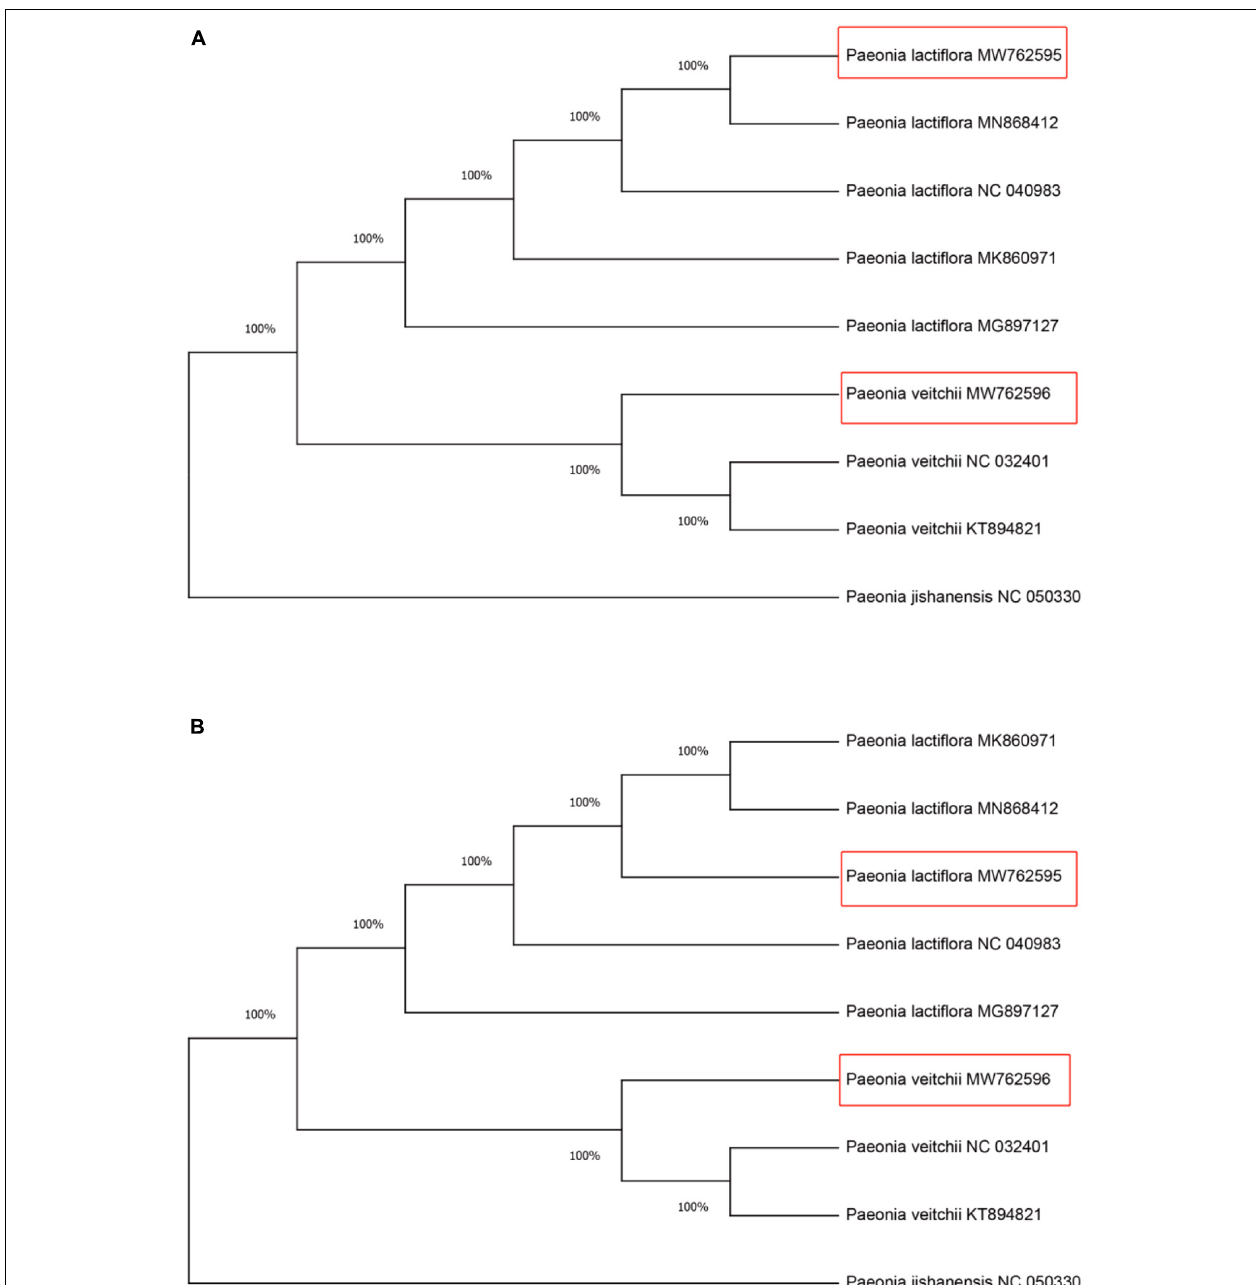
FIGURE 5 | Neighbor-Joining (NJ) tree of the Chishao species based on primers CS- ycf1b and CS- ndhF amplified sequences. (A) Primer CS -ycf1b ; (B) Primer CS -ndhF. Numbers beside nodes indicate statistical support for individual clades (percent), based on 1,000 bootstrap replicates of the data. Red boxes represent the assembled and annotated chloroplast genomes of Paeonia lactiflora and Paeonia veitchii in this study. Paeonia jishanensis was used as the outgroup. The GenBank accession numbers were listed following the species name.